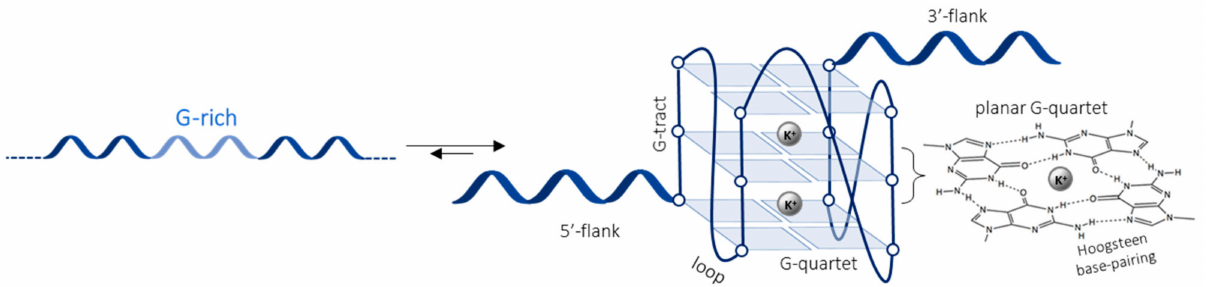
Figure 1. Schematic representation of G-quadruplex